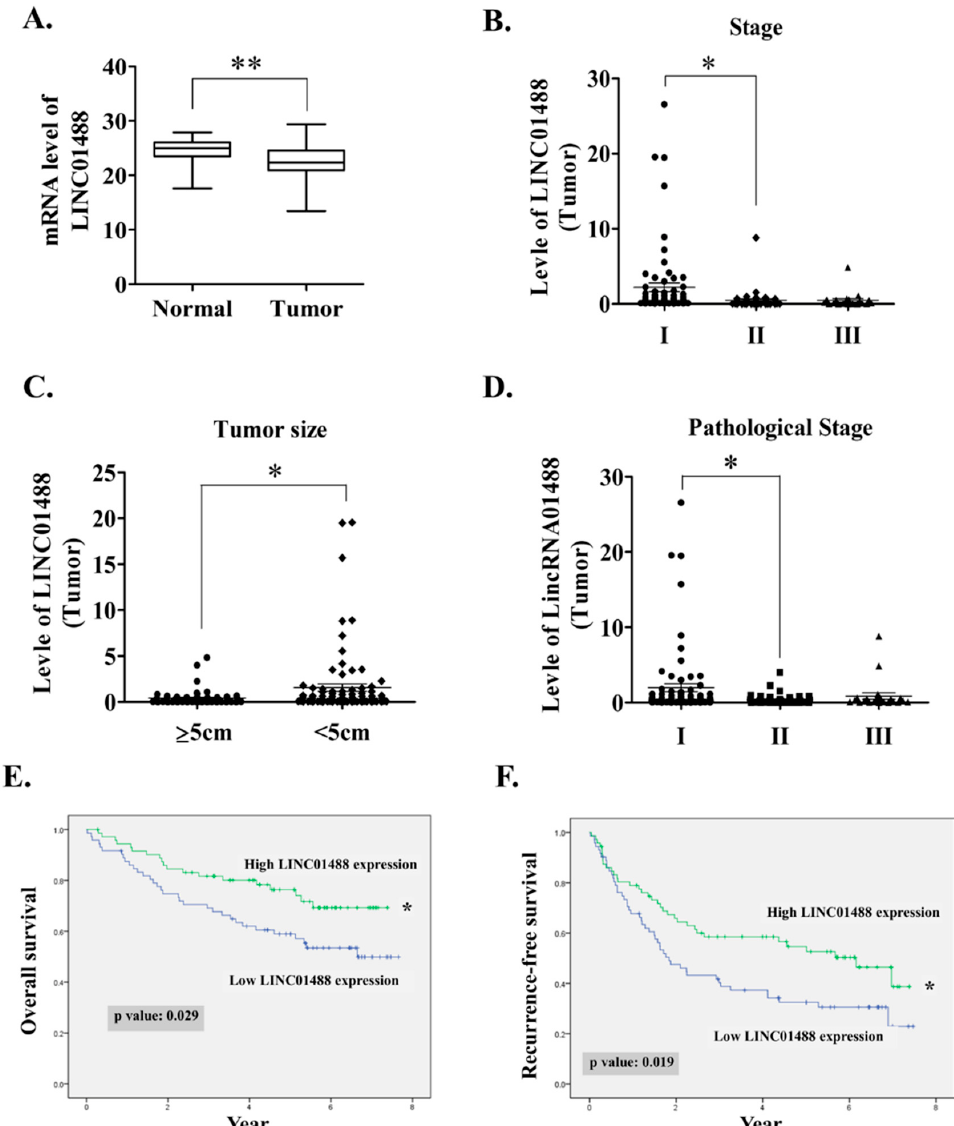
Figure 1. LINC01488 downregulation in human HCC tissues associated with favorable prognosis. ( A ) LINC01488 mRNA is highly expressed in normal relative to tumor tissue in 144 paired HCC specimens. Total RNA was isolated and analyzed via qRT-PCR. ( B – D ) Analysis of the clinicopathological significance of LINC01488 in HCC tumor (N:144) ( E ) Overall survival and ( F ) recurrence-free survival based on LINC01488 expression in HCC specimens determined using Kaplan–Meier analysis (N:144). Median expression levels of LINC01488 were used as the cut-off. Data are presented as means ± SD (* p < 0.05; ** p < 0.01).